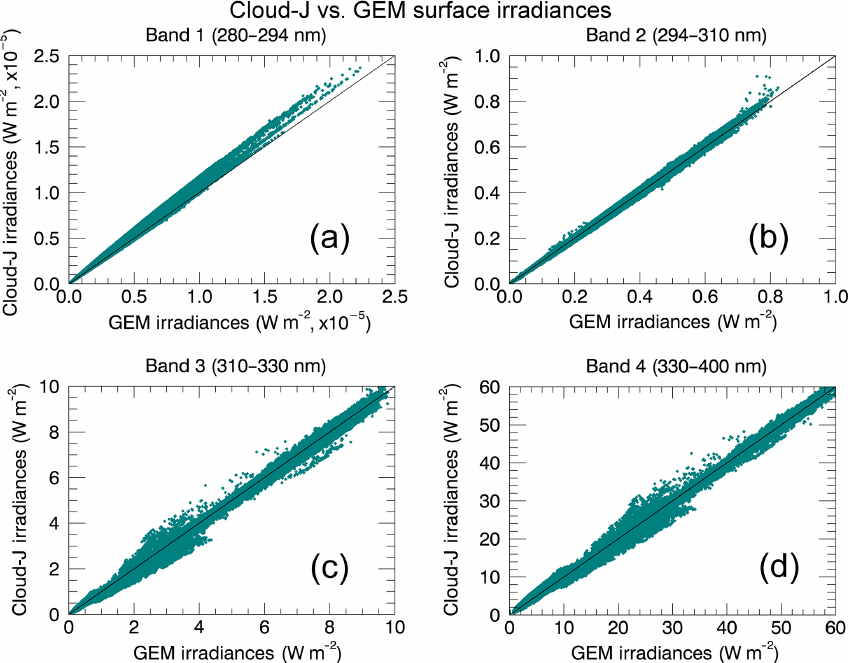
Figure 6. GEM broadband surface irradiances compared to simulated irradiances generated with Cloud-J, where the Cloud-J calculations were performed using the broadband absorption cross section and TOA solar fluxes associated with the correlated- k scheme used by GEM for each UV sub-band. Correlations represent the single-day irradiance contribution for 23 August